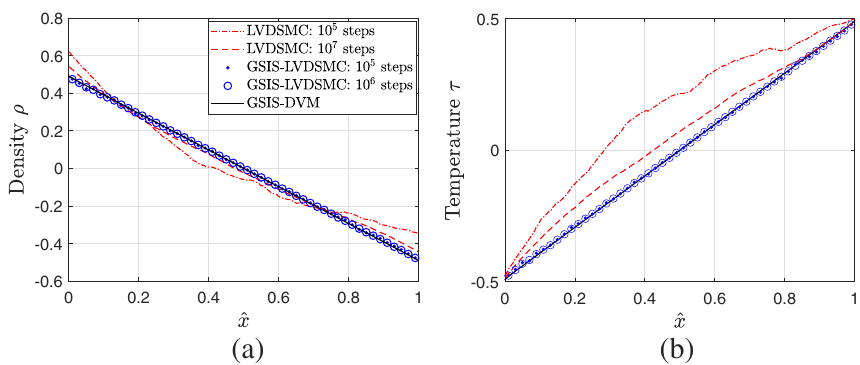
Fig. 11 Density and temperature profiles in the planar Fourier flow when Kn = 0.01 . Solid black lines: GSIS-DVM. Red lines: LVDSMC after 10 6 (dot dash line) and 10 7 (dotted line) time steps. Dots and circles: GSIS-LVDSMC after 10 5 and 10 6 time steps,